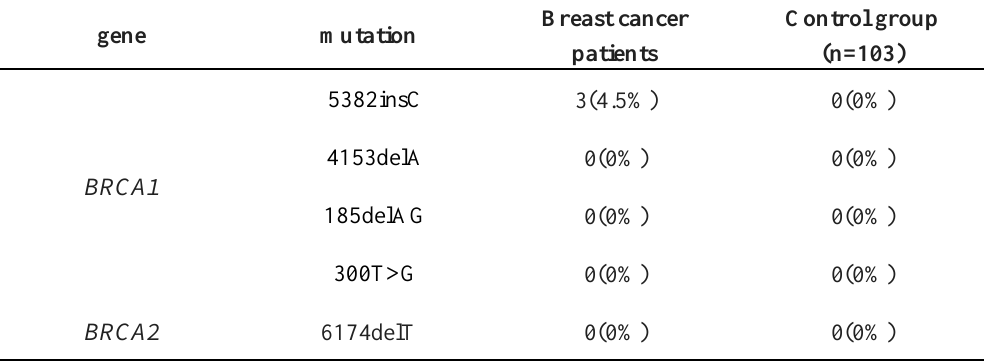
Table 2. The frequency of BRCA1 and BRCA2 mutations in patients with breast cancer and control